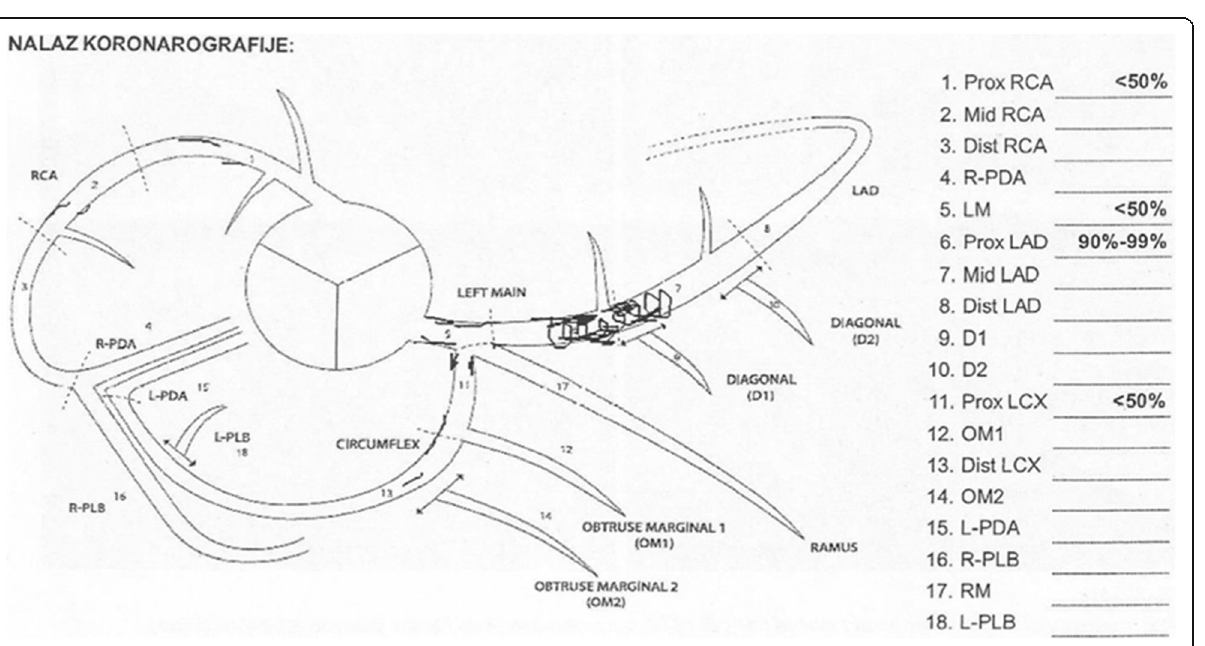
Fig. 3 Scheme of coronary angiogram showed stenosis of coronary arteries. Legend: This scheme describes the right (RCA) and left main (LM) coronary artery stenosis with a maximum narrowing of the proximal part of the left anterior descending artery (Prox LAD) in which the stent is